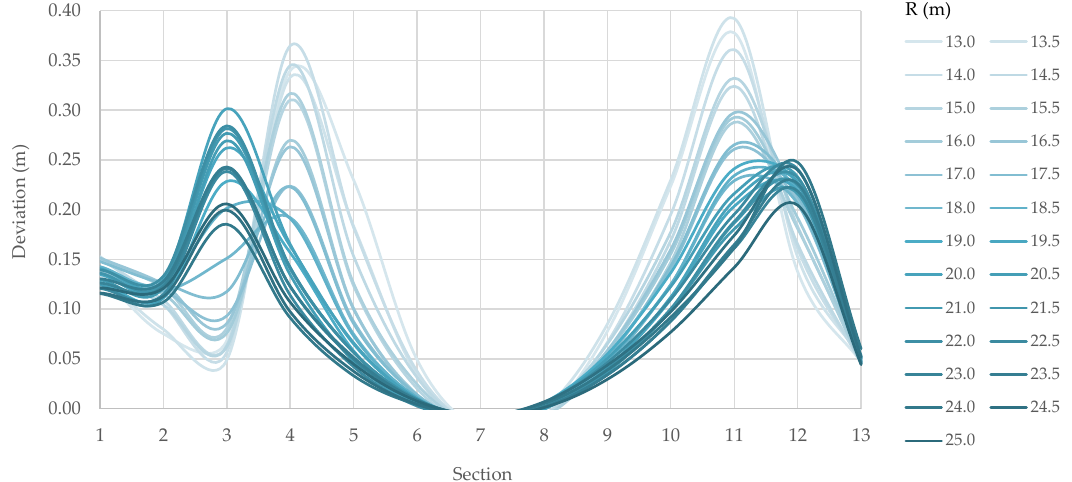
Figure 8. Body right-hand-side trajectory deviations.